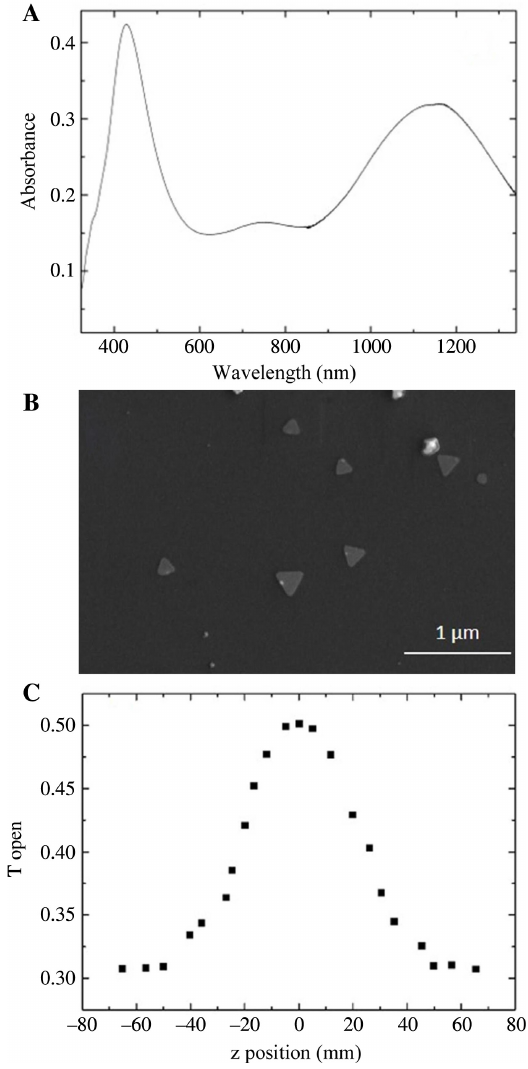
Figure 1: Characterization of the Ag nanoplates